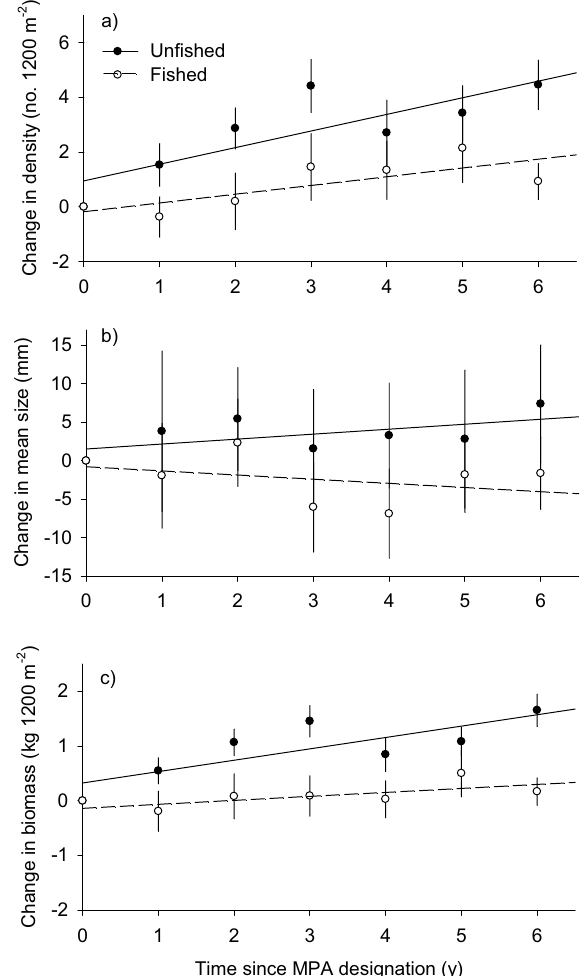
Figure 1. Annual changes in the: ( a ) density, ( b ) mean carapace length and ( c ) biomass of spiny lobster in fixed 1200 m 2 plots within MPAs and fished areas off the coast of Santa Barbara since the establishment of MPAs in 2012. Values are means with 95% CI. N = 17 and 19 for unfished and fished plots